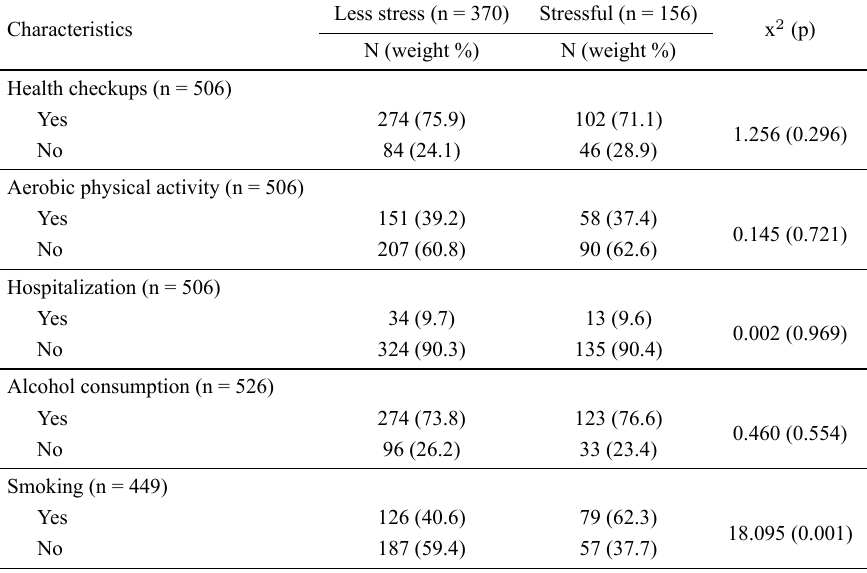
Table 2. Comparison of health-related characteristics according to stress level (n =